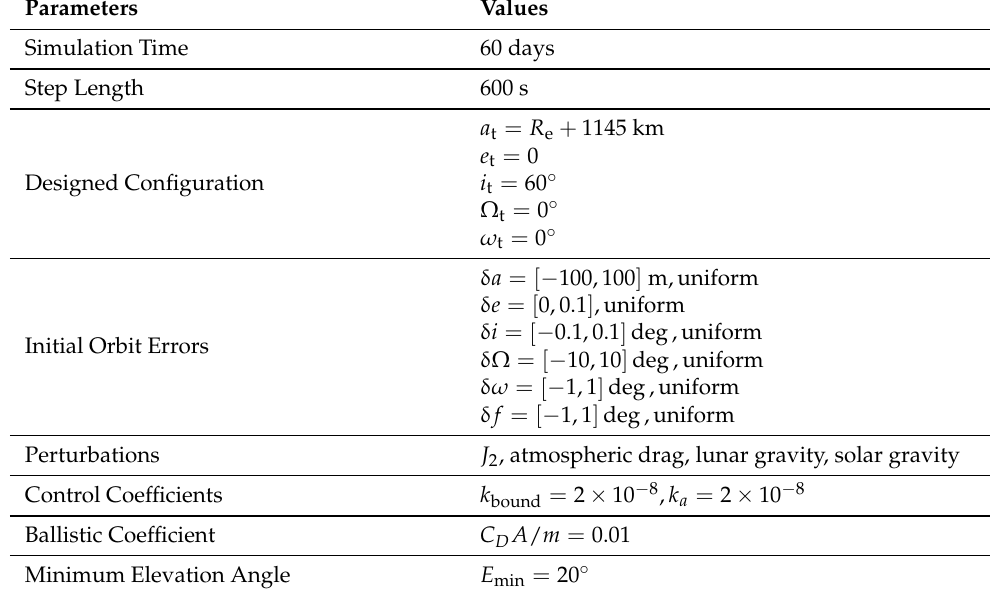
Table 3. Simulation parameters for the coplanar satellites